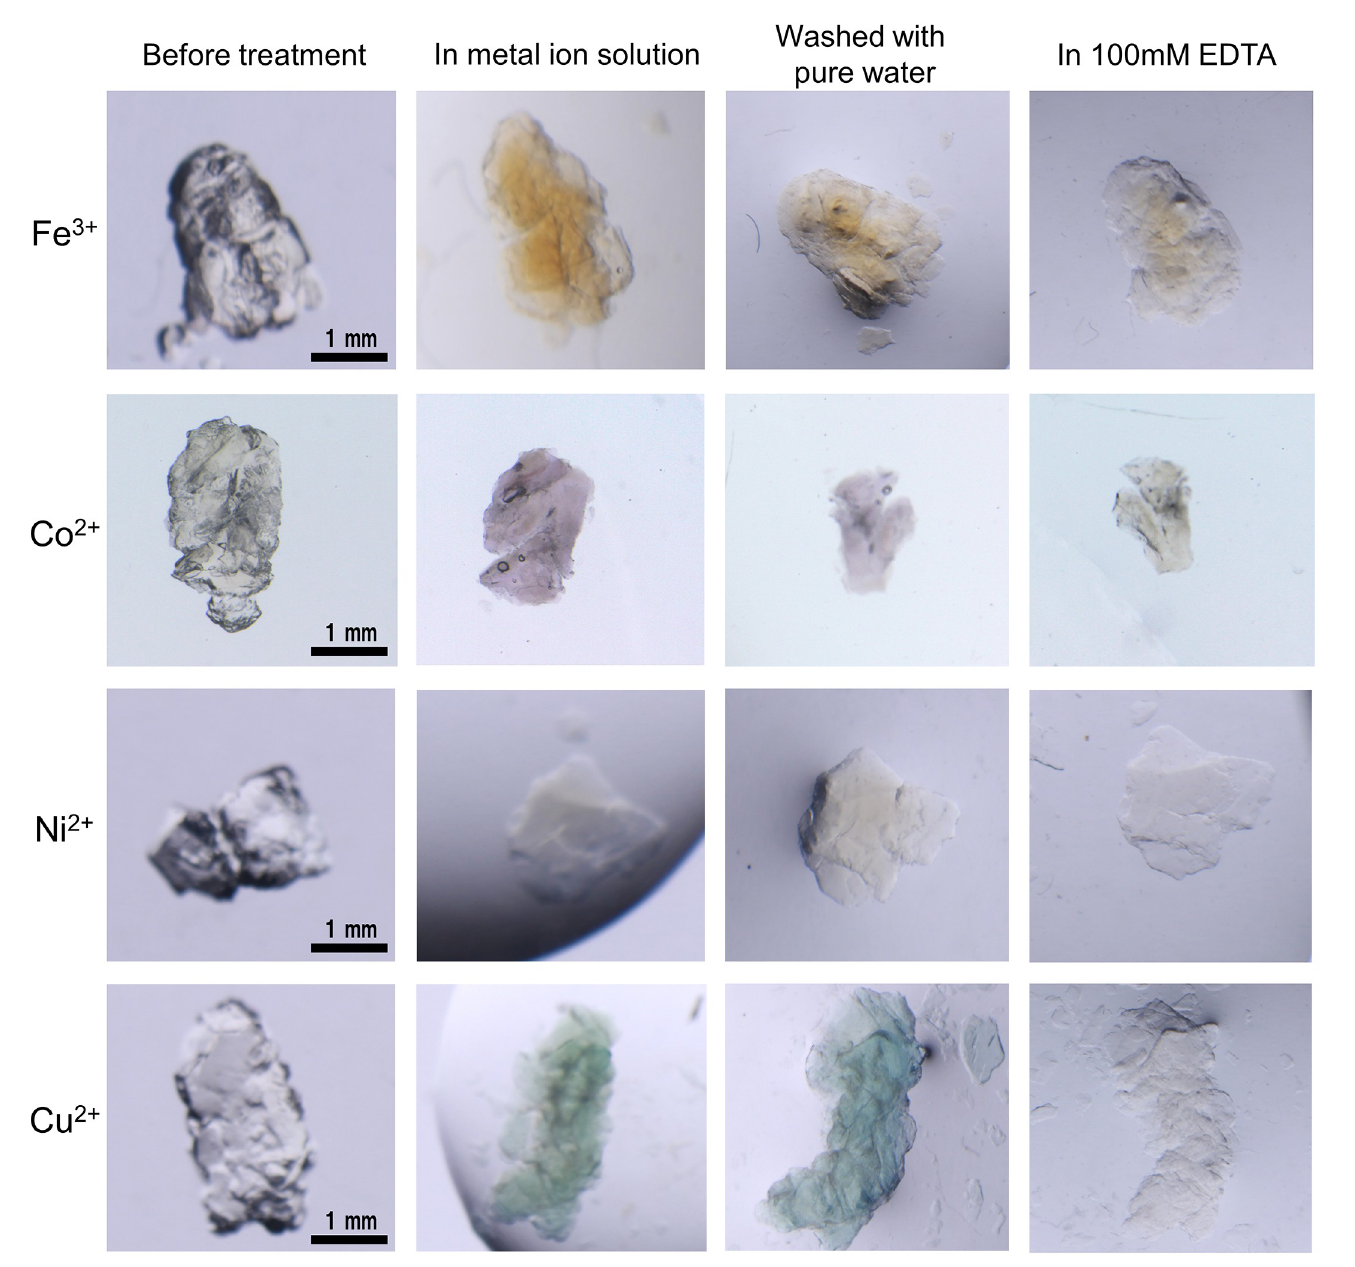
Fig 9. Metal adsorption of apoferritin hydrogel. Fe 3+ , Co 2+ , Ni 2+ , and Cu 2+ ions are investigated. The apoferritin hydrogel was incubated sequentially in the presence of 100 mM metal ions for 1 h, in pure water for 3 h, and in 100 mM EDTA for 1 h. Fe(III)Cl 3 , Co(II) acetate, Ni(II)Cl 2 , and Cu(II)Cl 2 solutions were used. The pictures of the hydrogel before the addition of the metal ions were taken under air, whereas other figures were taken under solutions. https://doi.org/10.1371/journal.pone.0259052.g009 binding to the amino acids in the hydrogel. The color of these metal ion-adsorbed hydrogels became pale upon incubation in the presence of 100 mM EDTA (Fig 9), showing that the apo- ferritin hydrogel adsorbs various metal ions and can release them in the presence of EDTA. These results support the hypothesis that the apoferritin hydrogel was constructed with ferritin subunits, maintaining their three-dimensional structures in metal binding.